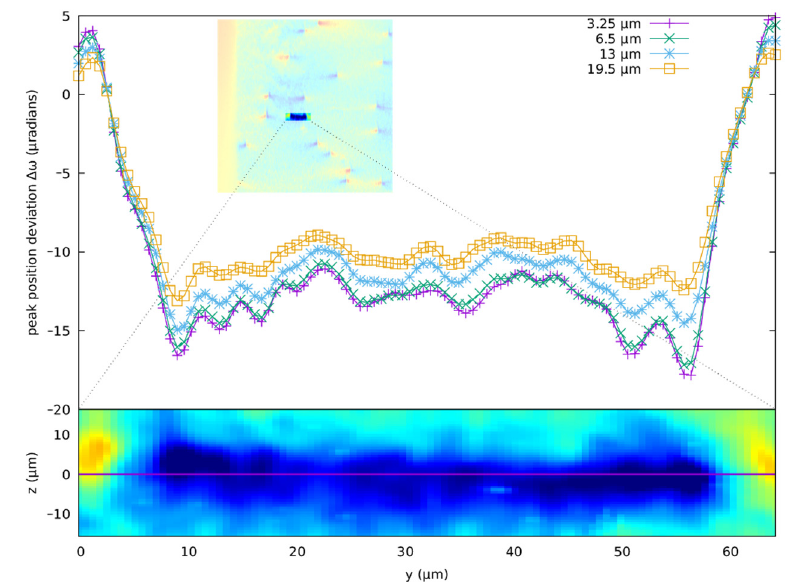
Figure 4. Plot of the angular misorientation ∆ ω between the region lying in between the dislocations and the matrix. The inset shows the left-down quarter of Figure 3, and the investigated area is shown as a blue rectangle. The different curves correspond to averaging over distances, perpendicular to line joining the core of the dislocations, going from ~3 to 20 µ m. The region in dark blue is ~20 µ m wide, and the corresponding angle α (see text) is ~10 µ